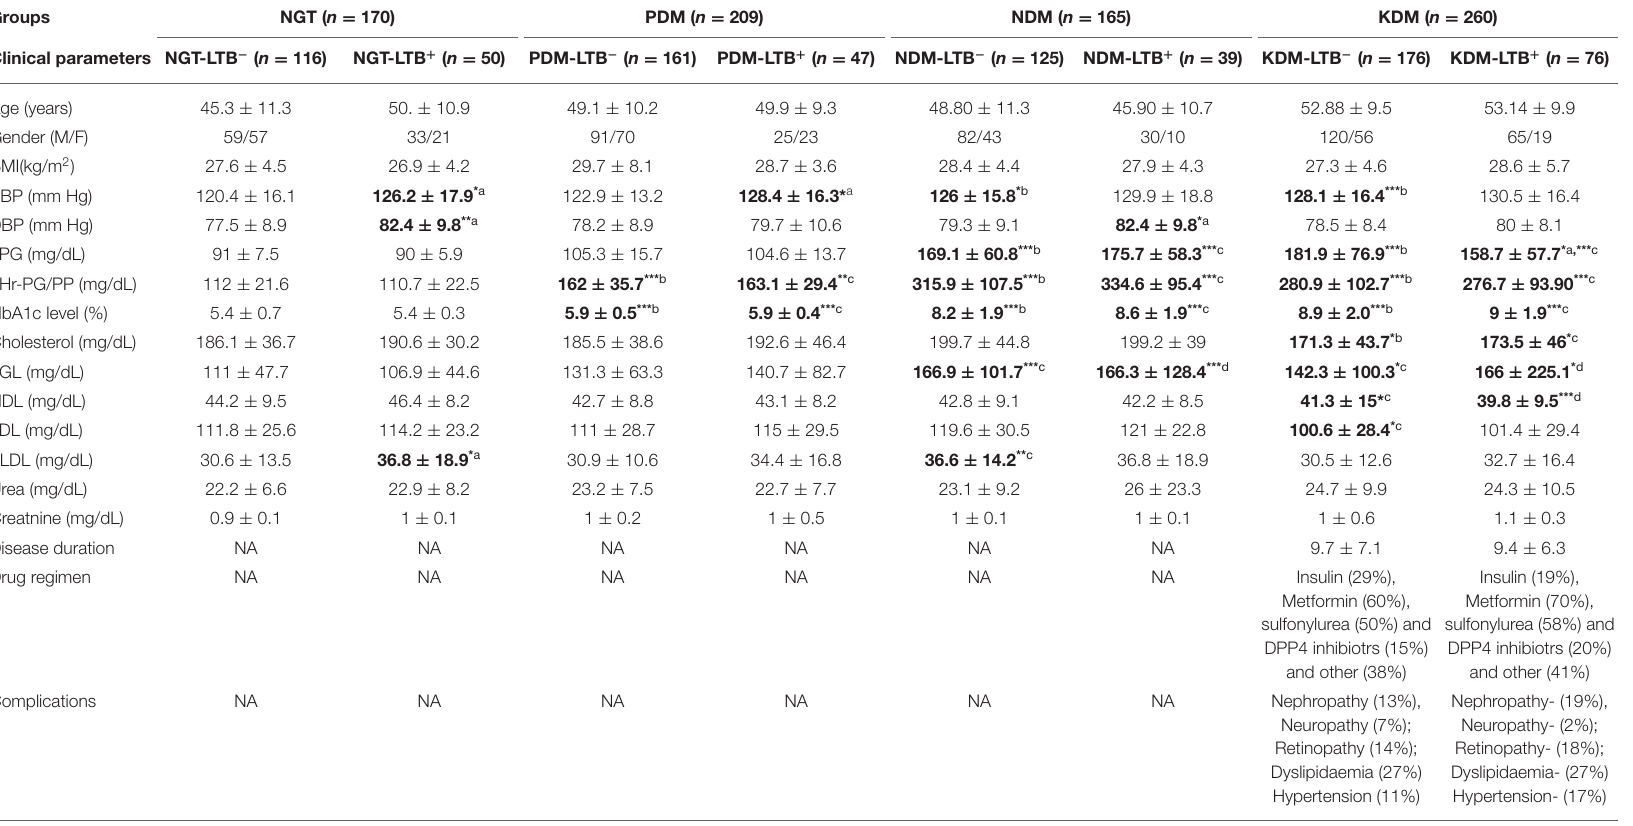
TABLE 1 | Clinical characteristic of the study groups.